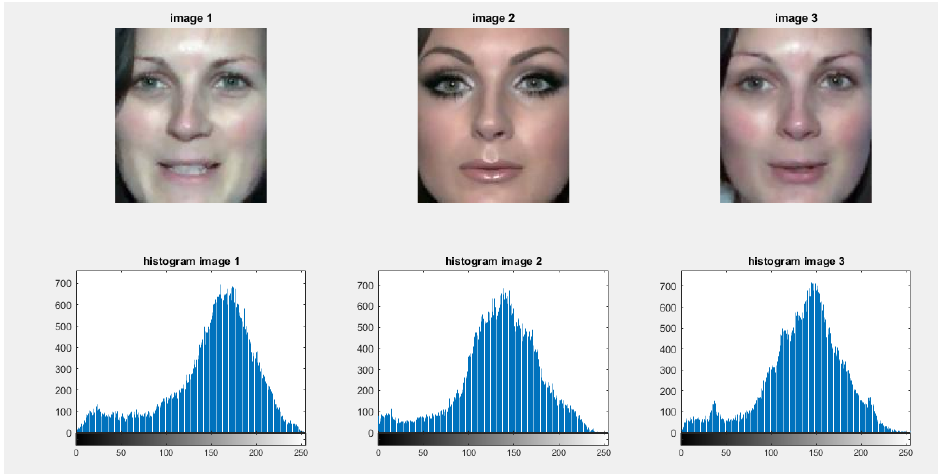
Figure 10. Histogram-based representation of person